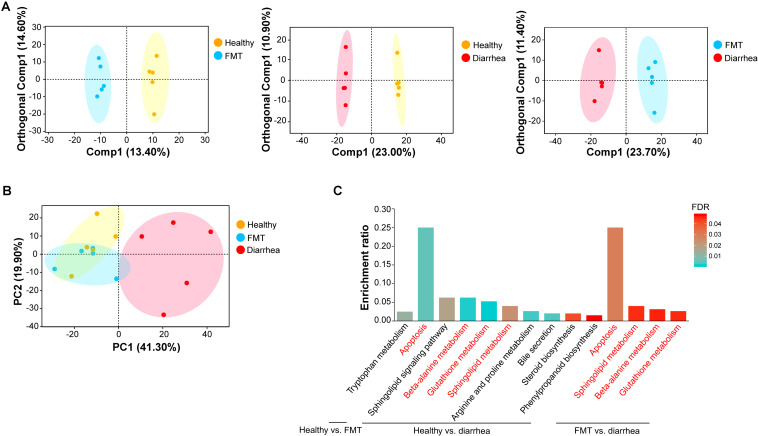
Multivariate statistical analysis of fecal metabolomic and pathway enrichment analysis of significant metabolites. (A) OPLS-DA score plots for each pair of groups. (B) PCA score plots for fecal samples in the three groups. Each point represents an individual sample. (C) Overview of metabolites that were enriched in the three pairwise comparisons. The red font indicates the KEGG metabolic pathways that were enriched in every pairwise comparison.